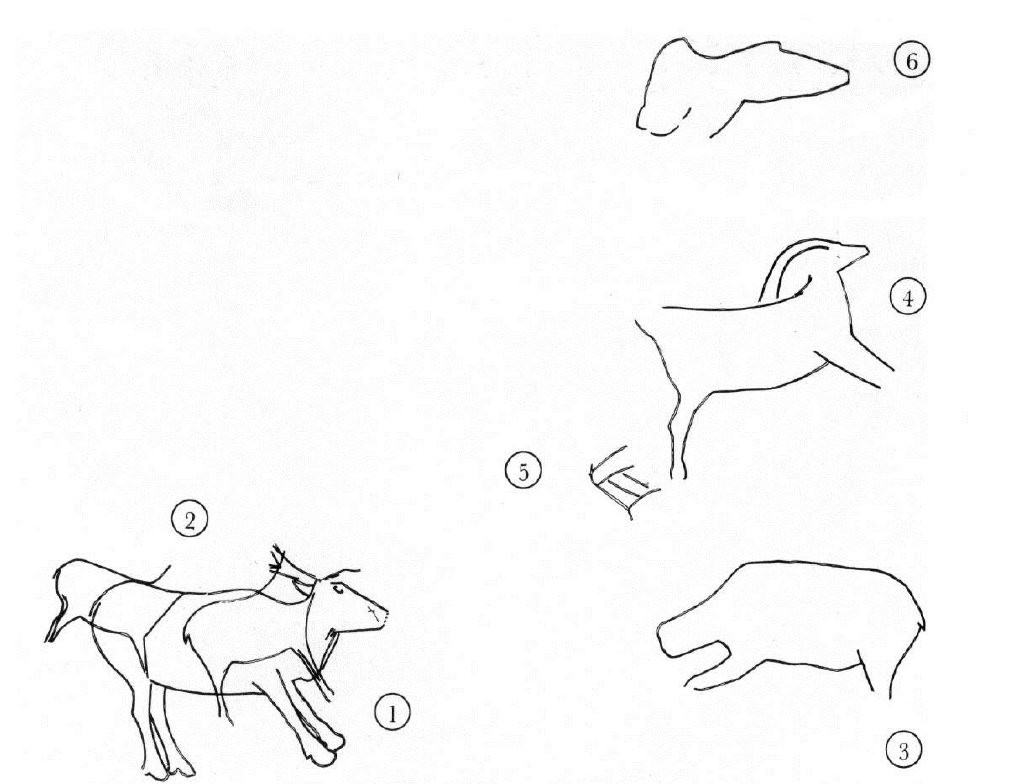
Figure 6. Details from the Engraved Pillar of the Isturitz Hall (Laplace, 1984)